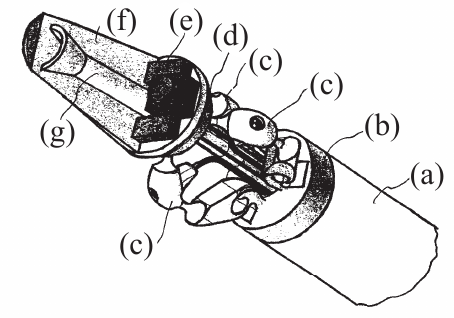
Figure 7. A view of an end-effector mounted in the platform: catheter ( a ); base link ( b ); legs ( c ); platform ( d ); on-board hardware ( e ); on-board end-effectors ( f ) and ( g